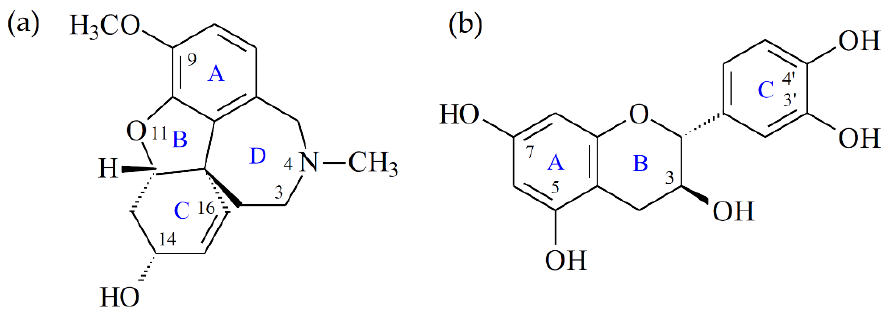
Figure 2. The chemical structures of galanthamine ( a ) and catechin ( 1 ) ( b